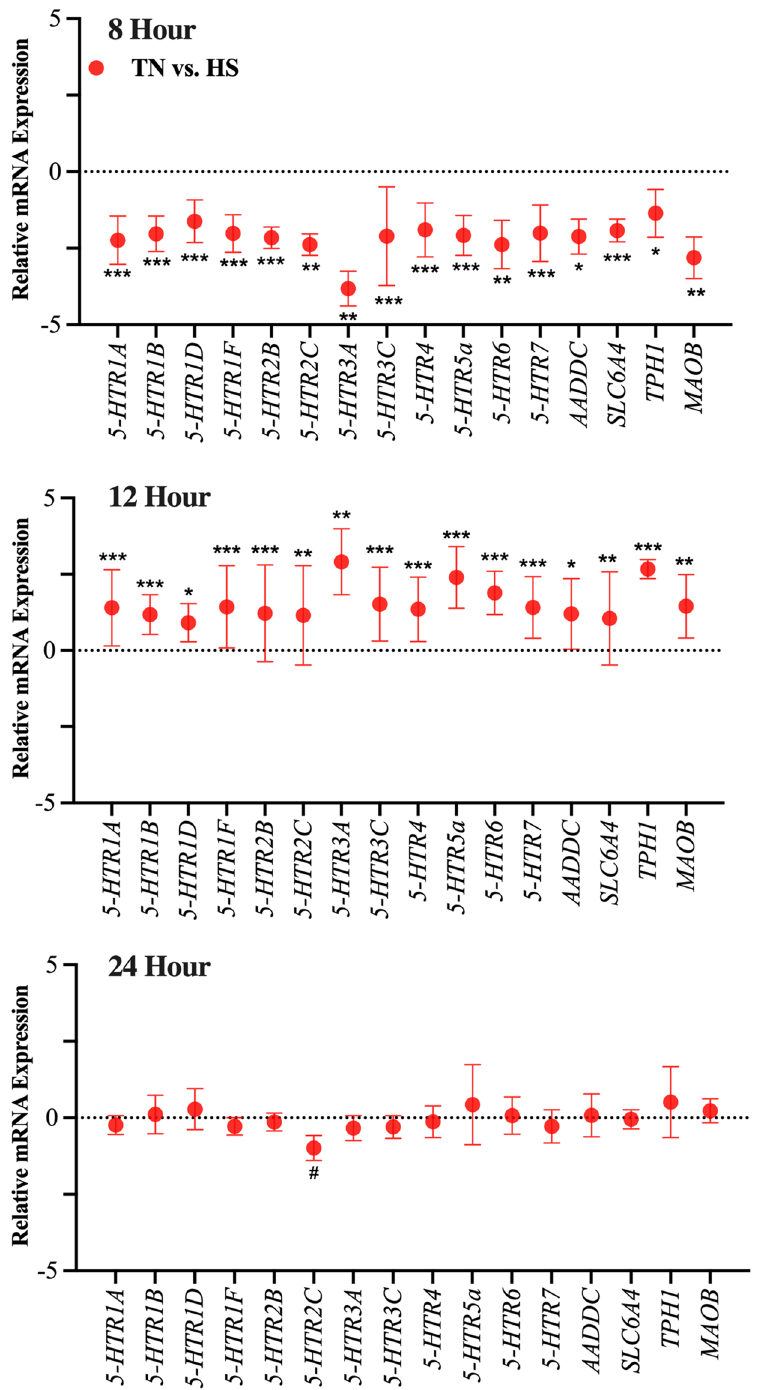
Figure 2. Main effect of incubation temperature. Gene expression of primary bovine mammary epithelial cells (pBMEC) exposure to either thermoneutral (37 °C, TN) or heat shock (41.5 °C, HS) culture conditions for 8-, 12- or 24-h. Data is presented as relative mRNA expression (∆∆Ct = ∆Ct TN (CON) − ∆Ct (HS)) ± standard error of the mean (SEM). Positive and negative ∆∆Ct indicates upregulation and downregulation, respectively. Significance declared at (*) P value ≤ 0.05, (**) P value ≤ 0.001 (***) P value ≤ 0.0001 and (#) denotes a statistical tendency at 0.05 < P value ≤